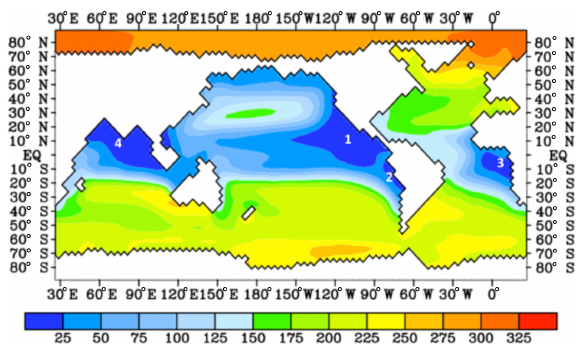
Figure 3. Locations of the OMZ at 450m depth simulated by HAMOCC 2.0 (reference experiment): 1, eastern North Pacific OMZ; 2, eastern South Pacific OMZ; 3, eastern South Atlantic OMZ; and 4, Indian